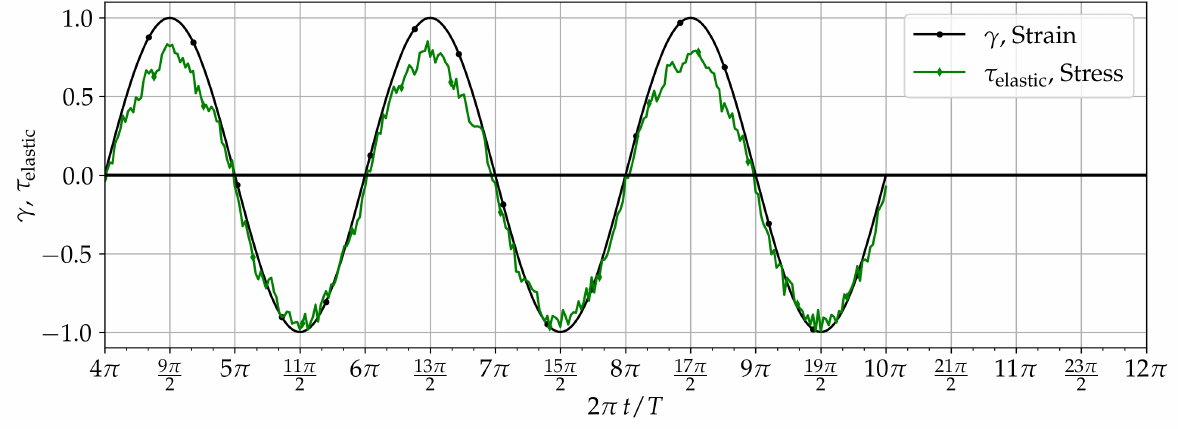
Figure 10. Shear stress τ and strain γ vs. time in the example elastic